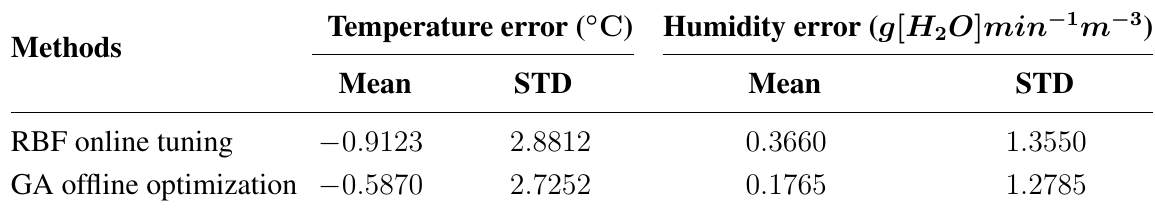
Table 3. Performance Comparison between RBF online tuning and GA offline